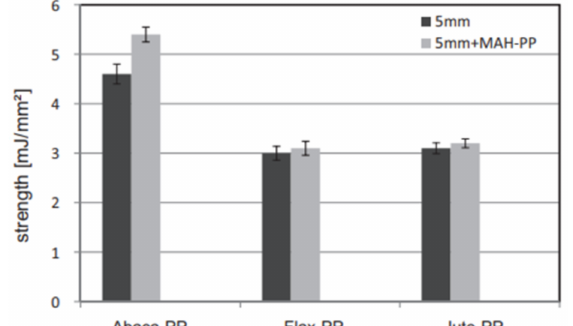
Figure 13. Notch Charpy strength of abaca/jute/flax fiber–PP composites comparison with and without MAH–PP. Reprinted with permission, Elsevier.